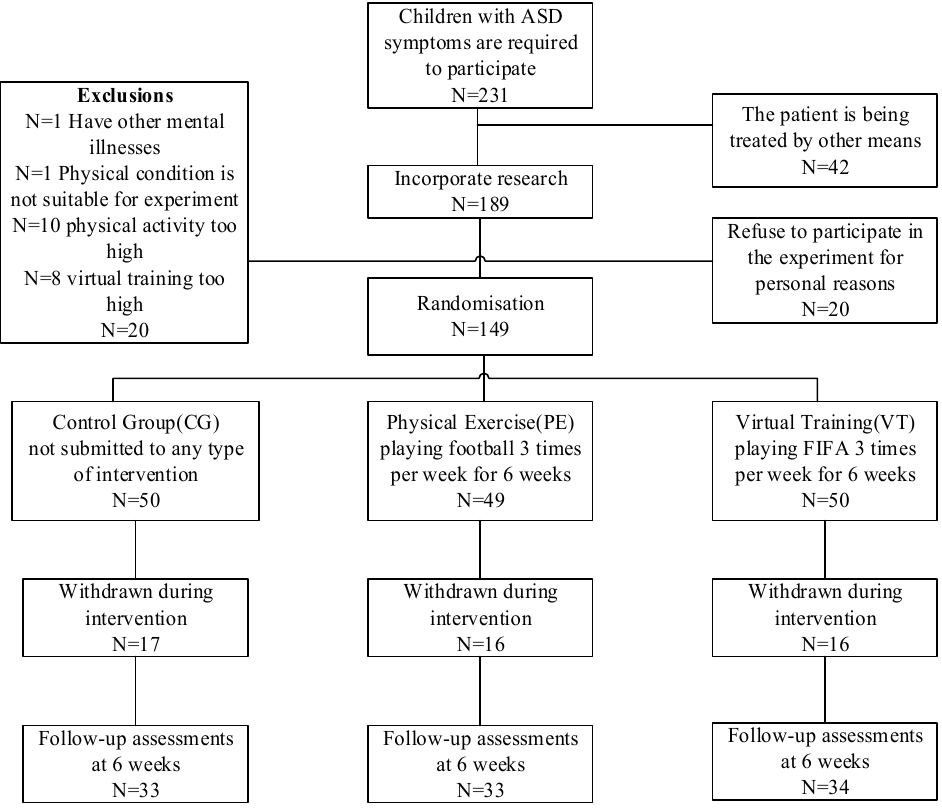
Figure 1. Participant flowchart across the study.